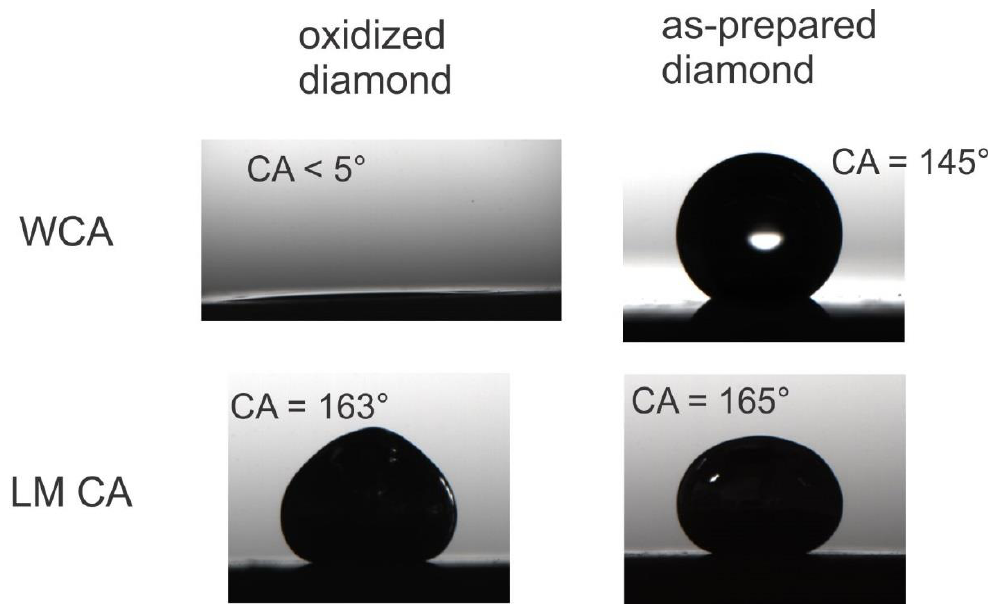
Figure 2. Water contact angle (WCA) and LM contact angle (LM CA) on oxidized and as-prepared rough diamond coating on Ti alloy.